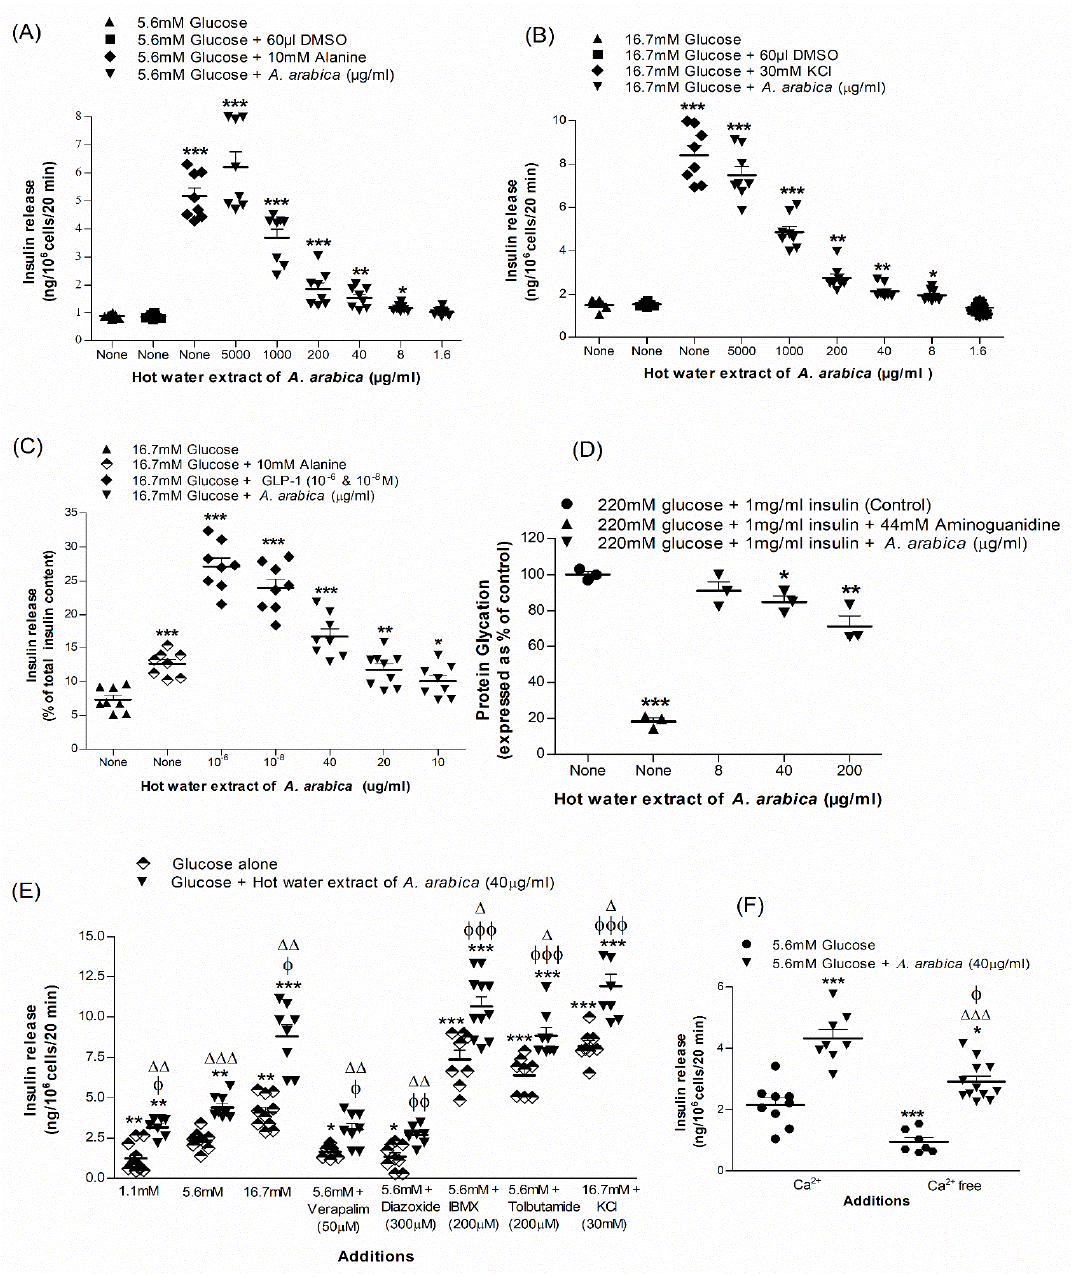
Figure 1. Dose-dependent effects of hot-water extract of A. arabica bark on insulin release from ( A , B ) BRIN-BD11 cells and ( C ) islets of Langerhans, ( D ) protein glycation, ( E ) insulin secretion in the presence of established stimulators or inhibitors and ( F ) absence of extracellular calcium. Values are the mean ± SEM for n = 4–8 for insulin release and n = 3 for protein glycation. * p < 0.05, ** p < 0.01 and *** p < 0.001 compared to control (5.6/16.7 mM glucose and 220 mM glucose + insulin (1 mg/mL)). φ p < 0.05, φφ p < 0.01 and φφφ p < 0.001 compared to 5.6 mM glucose in the presence of the extract. ∆ p < 0.05, ∆∆ p < 0.01 and ∆∆∆ p < 0.001 compared to respective incubation in the absence of the extract.